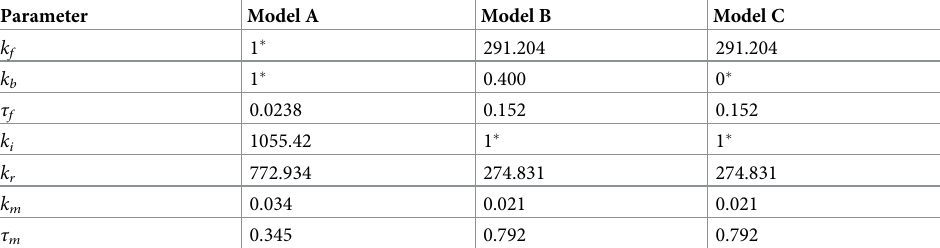
Table 4. Optimal parameters for the dual process model